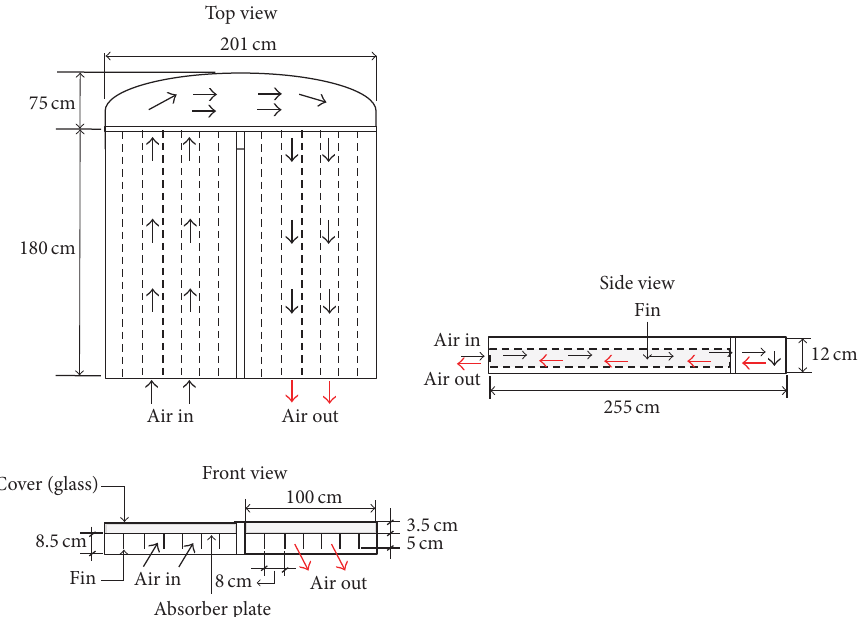
Figure 2: Dimensions of a single-pass solar collector with